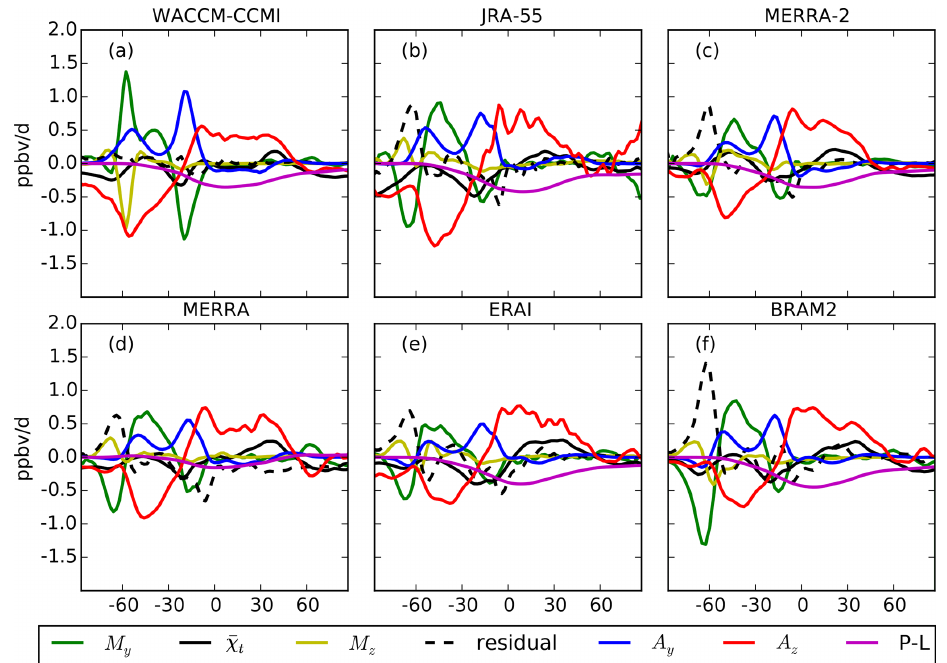
Figure 2. Same as for Fig. 1 but for